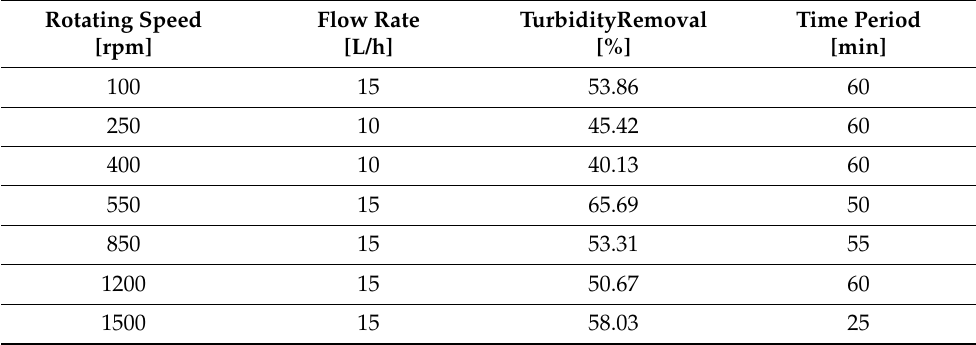
Figure 3. Turbidity removal dependence on WW flowrate at different disc rotational speeds: ( a ) 100 rpm, ( b ) 550 rpm, ( c ) 850 rpm, ( d ) 1200 rpm . Table 1. Maximum values of turbidity removals and the corresponding investigated SD operating parameter values .